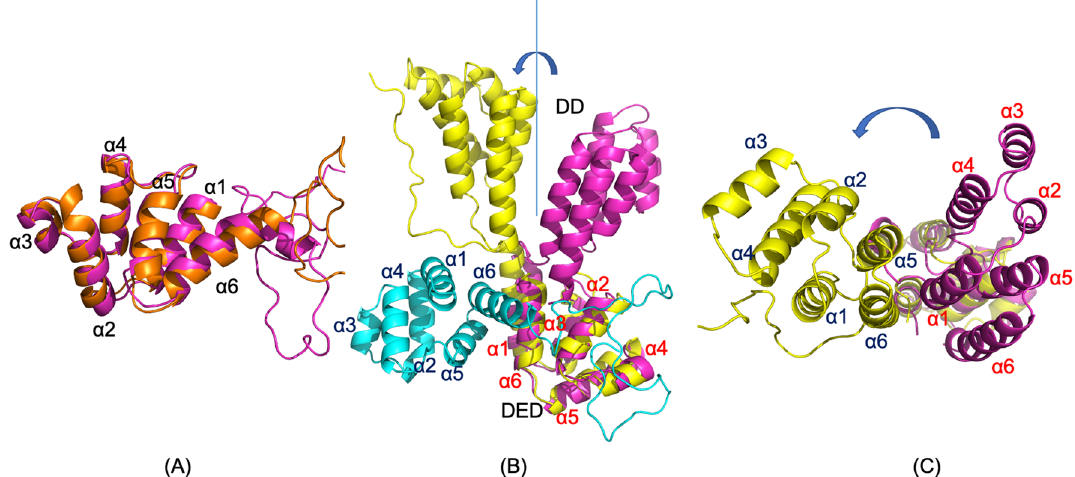
Figure 4. The simulated complex structure of PEA-15pp/FADD. ( A ) PEA-15pp in the complex (orange) is superimposed with free-form PEA-15pp (magenta) with the RMSD of 0.803 Å before the kink on helix α6. There is no significant conformational change between the free and bound forms. ( B ) FADD in the complex (yellow) is superimposed with the NMR structure of intact FADD, 2GF5 (magenta), over DED residues (RMSD 2.118 Å). PEA-15pp in the complex is colored cyan. DED–DED interaction in the complex is orthogonal in directions. The FADD DD in the complex rotated about 90° from the free form around the linker between the two domains. ( C ) same as ( B ) but observed from the top of FADD DD to illustrate the relative positions of the six helices on DD. PEA-15pp is not shown for clarity. The molecular structures were visualized and generated using PyMOL version 2.4 (http:// www. pymol. free and FADD-bound form are consistent with our initial NMR data, which indicated that phosphorylation at S104 and S116, mimicked by serine to aspartic acid mutation, on the C-terminal tail stimulates a conformational change at the DED, and FADD binding does not induce additional changes of DED conformation 22 . The NMR data and the current MD simulations both suggest that phosphorylation of C-terminal serine residues is enough to modulate the DED structure, converting the protein into a conformation that optimally binds to FADD. The FADD structure exhibits significant changes upon PEA-15pp binding. The FADD DED in the complex does not show any significant changes from the free FADD (PDB ID 2GF5), with backbone RMSD between the